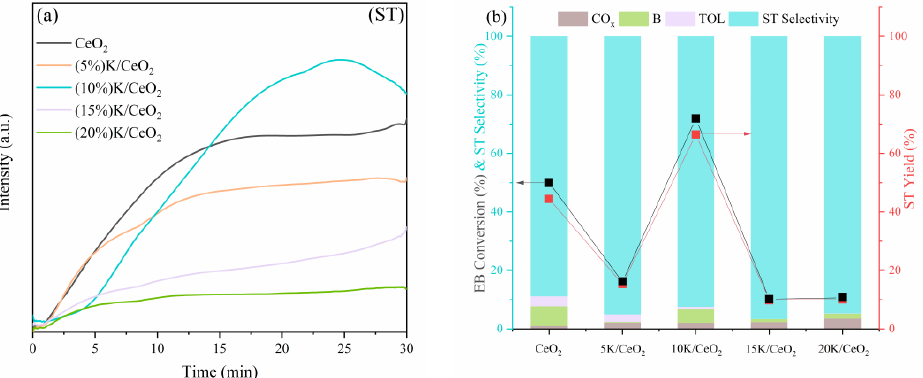
Figure 7. EB catalytic performance of CeO 2 doped with different ratios of alkali metal K. ( a ) styrene (ST) mass spectra of n%K/CeO 2 at 500 ◦ C; ( b ) product distribution of n%K/CeO 2 at 500 ◦ C ( n = 0, 5, 10, 15, 20). Experimental conditions: temperature rise rate 10 ◦ C/min, T EB = 25 ◦ C, flow rate 25 mL/min, atmosphere Ar, catalyst dosage 500 mg, space velocity = 7.5 h − 1